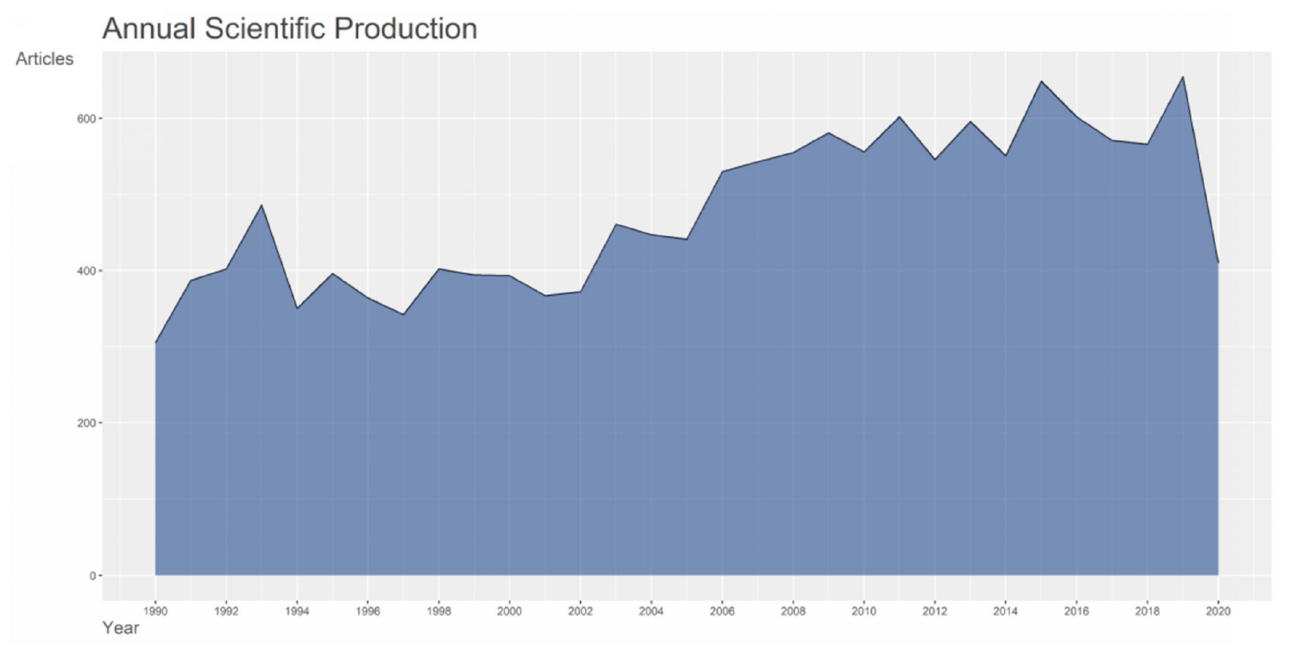
Figure 1. Number of articles published per